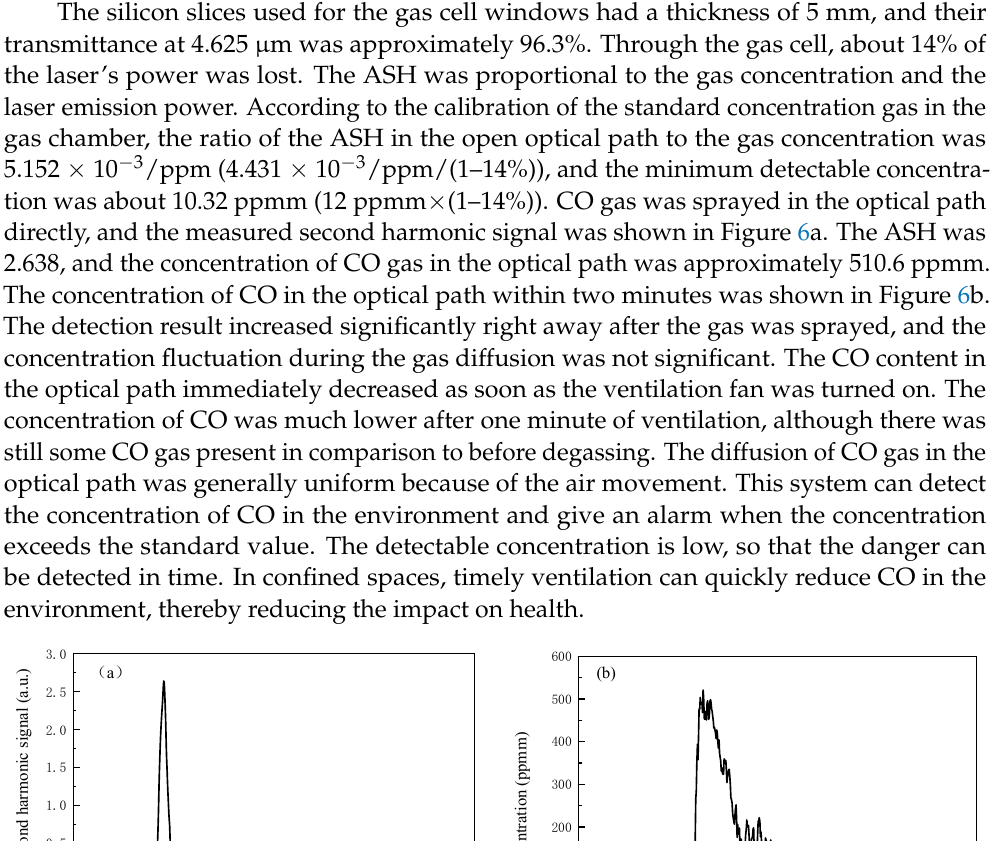
Figure 5. The fluctuation of ASH with different concentrations of CO in the gas chamber.